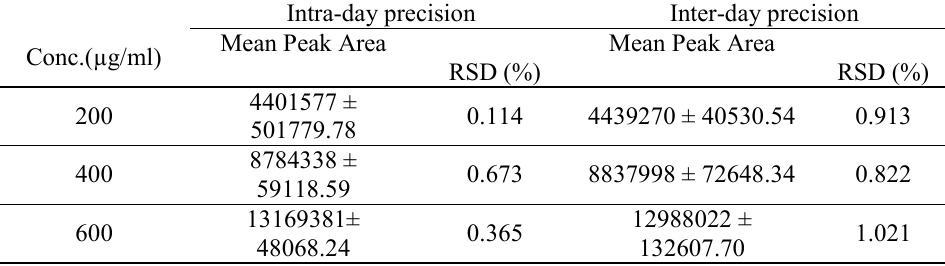
Table 3. Intra and inter - day precision for Dorzolamide (n =